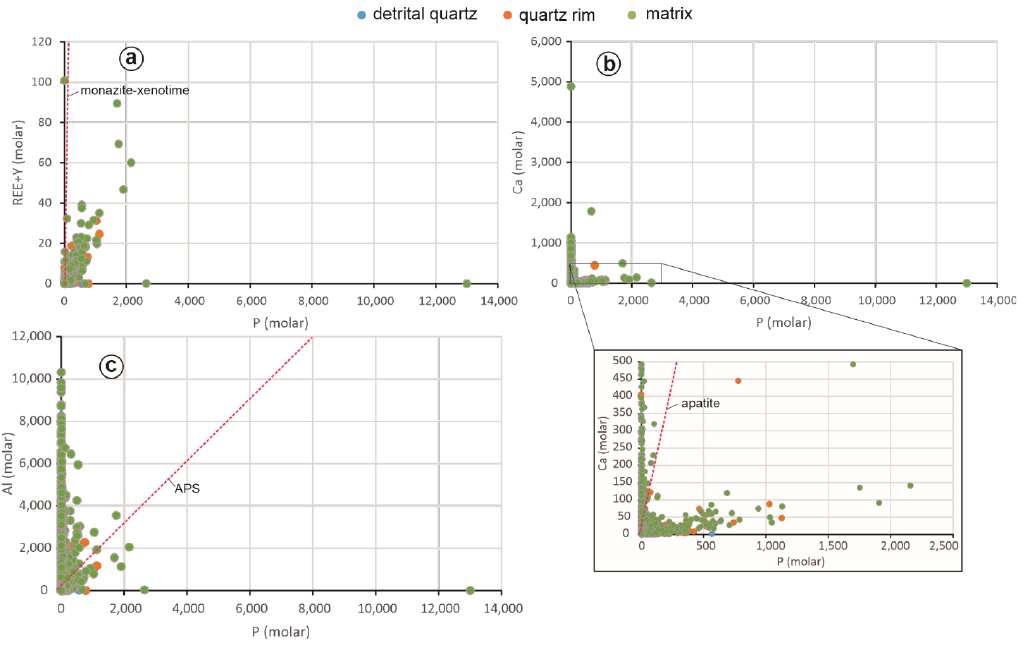
Figure 10. Bivariate diagrams showing relationships between molar values of P, Ca, REE + Y and Al and expected trends for apatite (Ca 10 (PO 4 ) 6 (OH,F,Cl) 2 ), monazite – xenotime ((REE + Y)PO 4 ), and APS minerals (AB 3 (XO 4 ) 2 (OH) 6 ), where A can be Na, K, Ca, Ba, Sr, Ag, Pb, U and REE, B can be Al, Fe, Cu and Zn, and X is either P or S. An average mass of 152 was used in converting the mass concentrations to molar values for REE and Y. For the trend of APS minerals, the B-site is presumed to be dominated by Al. See the text for detailed discussion of the deviation of the trends from the expected lines of monazite ( a ), apatite ( b ) and APS minerals ( c ).